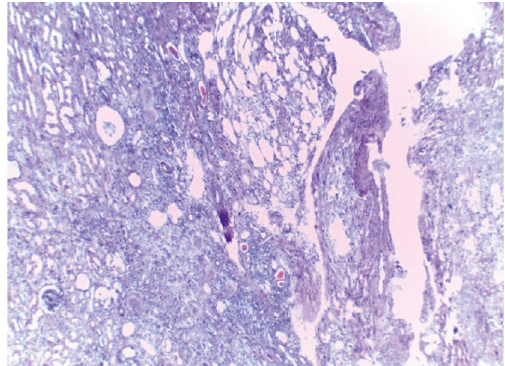
Figure 6: On low magnification, the left side shows normal- looking renal tubules and the right side shows the fatty tissue with round blue cells consistent with tumor cells.